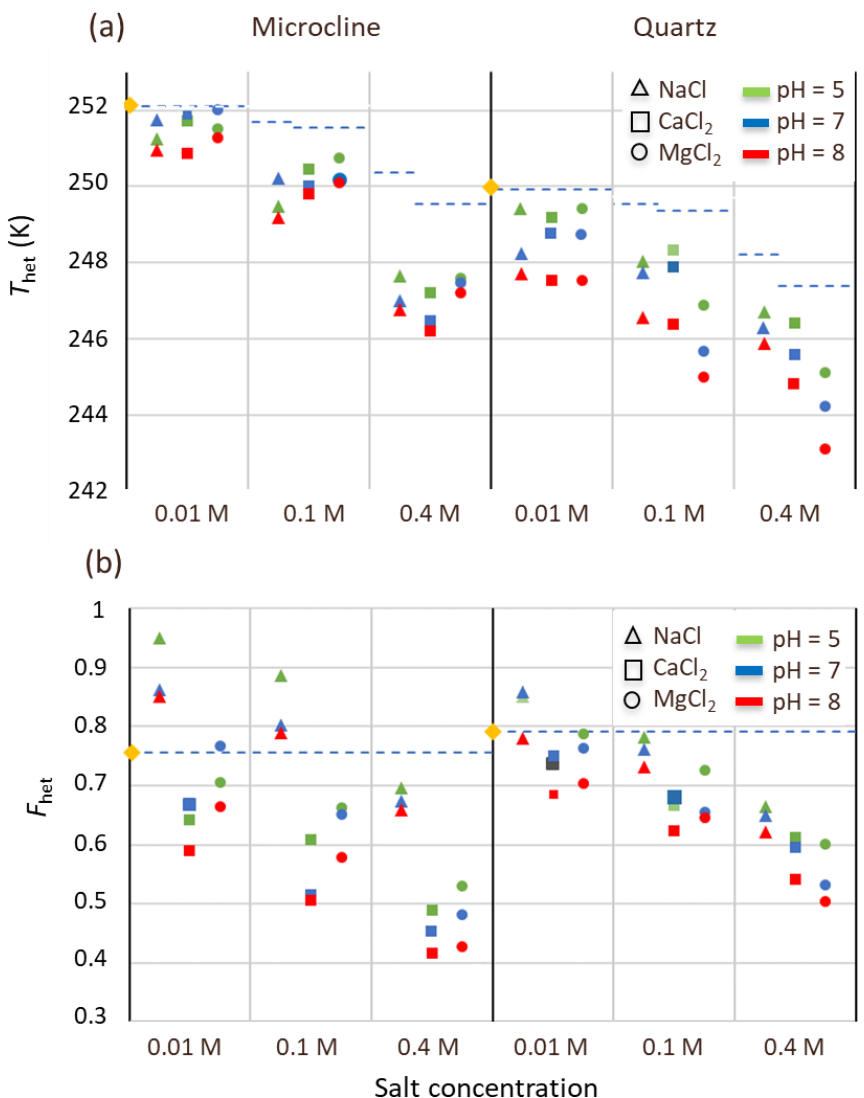
Figure 8. (a) Heterogeneous freezing temperatures ( T het ) and (b) F het of microcline (2wt%) and quartz (1wt%) in aqueous solutions of the salts NaCl (triangles), CaCl 2 (squares), and MgCl 2 (circles) at the salt concentrations 0.01, 0.1, and 0.4M, and for pH 5 (green), pH 7 (blue), and pH 8 (red). Yellow diamonds represent T het and F het values for pure microcline (2wt%) and quartz (1wt%) in Milli-Q water. The blue dashed line in panel (a) represents the freezing temperature according to the water activity criterion; in panel (b) , it marks the frozen fractions of the minerals in pure